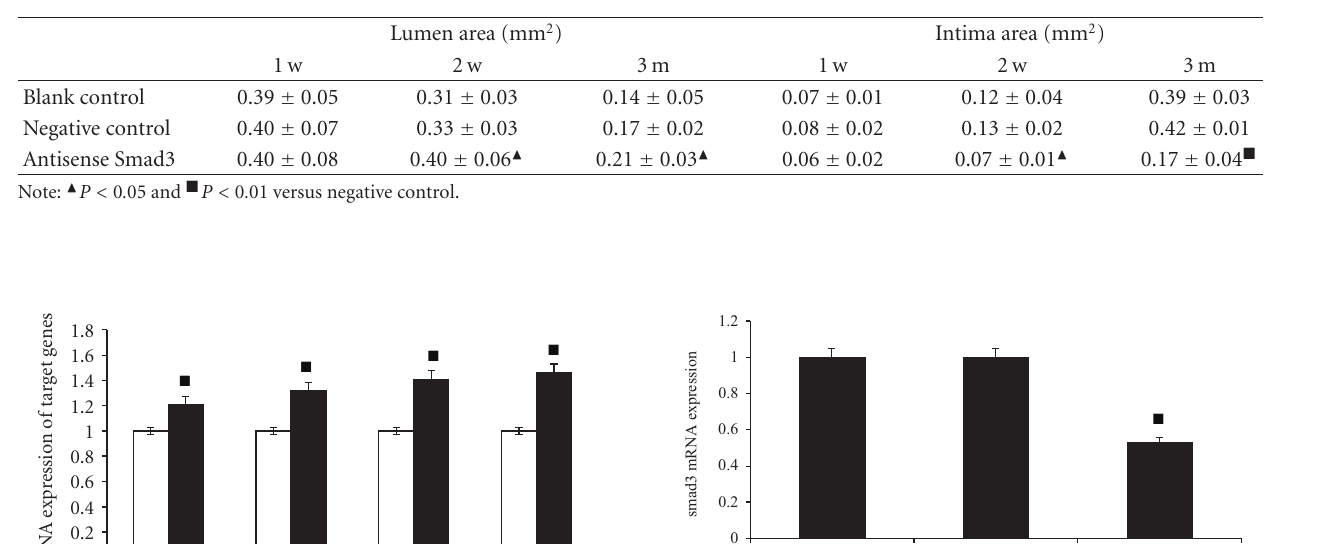
Table 2: Vascular lumen area and intima area in di ff erent groups.